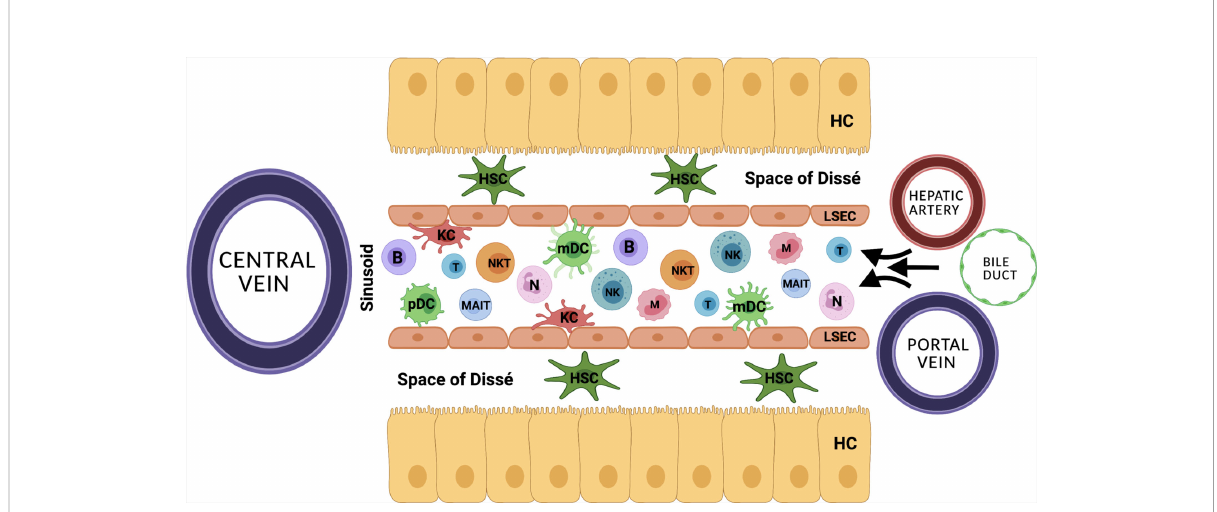
FIGURE 1 The distinctive anatomical vascular system allows for continuous exchange of immunological information. HC, hepatocyte; HSC, hepatic stellate cell; KC, Kupffer cell; B, B cell; T, T cell, NK, natural killer cell; NKT, natural killer T cell; N, neutrophil; MAIT, mucosa associated invariant T cell; mDC, myeloid dendritic cell; pDC, plasmacytoid dendritic cell; LSEC, liver sinusoidal endothelial